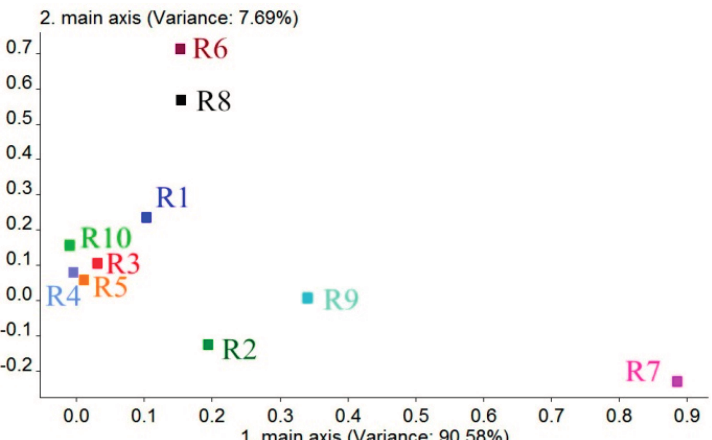
Figure 6. Loadings for BRPH volatiles.